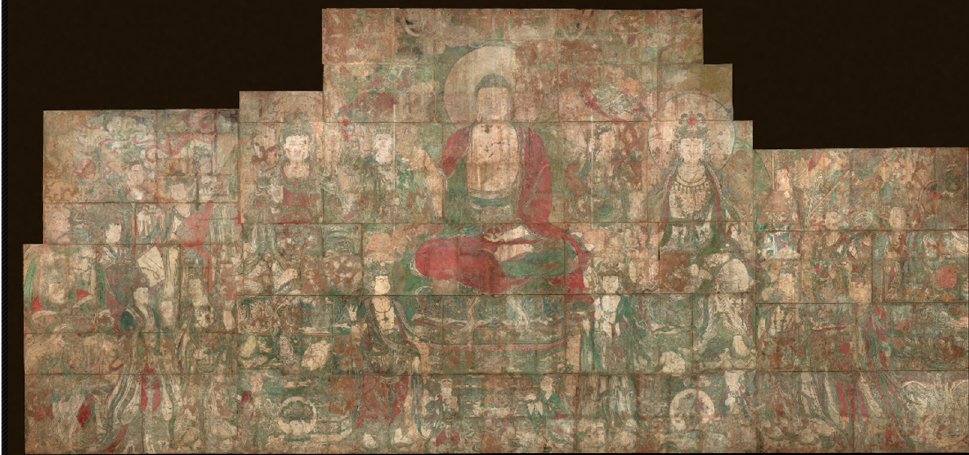
Figure 11. The Assembly of Tejaprabh ā , The Nelson ‐ Atkins Museum, Ink and mineral colors on clay, From Guangshengsi Lower Monastery 廣勝下寺 , Shanxi Province, China, 713.74 cm × 1483.36 cm, Early the 14th century.